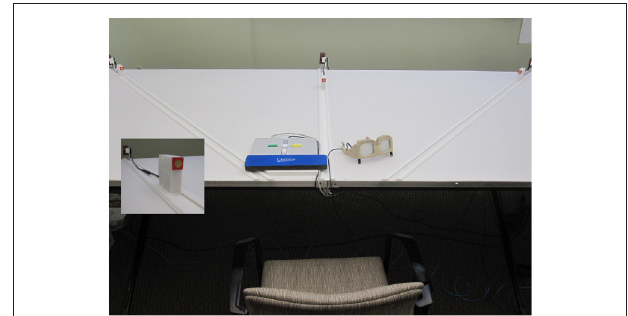
FIGURE 6 | Setting for judging reachability. Participants were seated centrally in front of the height adjustable reaching apparatus, 25cm from the table edge. The table’s height was set underneath breast-level. Distance-measurements were possible using measurement-tapes mounted at the end of each track. Dimension specifications allowed for measuring millimeter increments. Participants wore plato-goggles (here: opaque) throughout the experiment to control for visual feedback and to allow for RT measurements. Goggles were opened at the beginning of each trial. The positioning of the response box reflects an affordance judgment block for the left